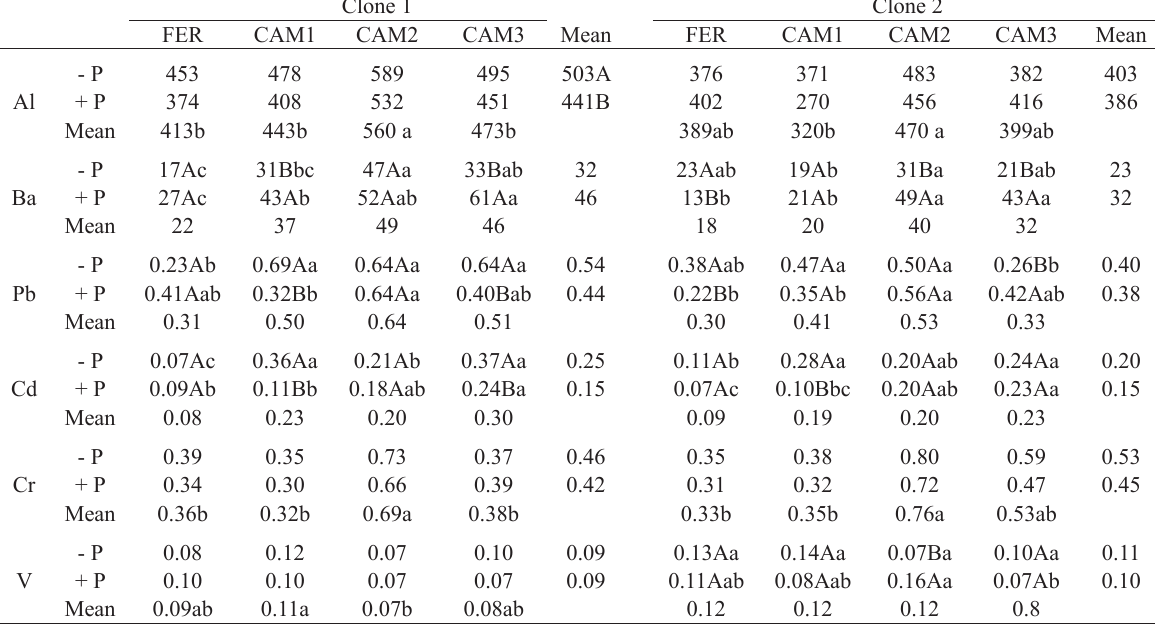
The Al, Ba, Pb, Cd, Cr and V contents (mg kg -1 ) in leaves of yerba mate clones in response to P fertilization, at 210 days after installation of the experiments 1